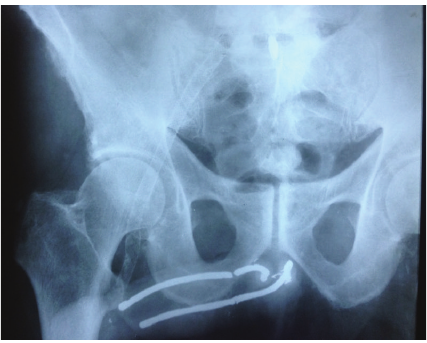
Figure 1: Pelvic radiography, showing total fracture of the medial portion of the right and left rods and probable fracture of the base of both rods.